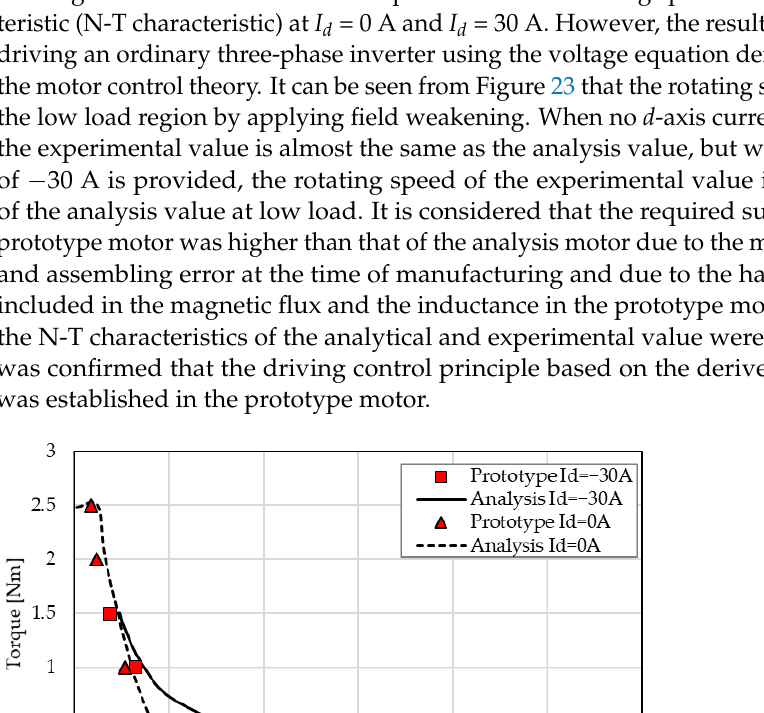
( b ) Figure 25. Analytical U-phase back e.m.f. before and after irreversible demagnetization at 1000 r/min: ( a ) waveforms; ( b ) FFT results. The prototype motor determines whether the magnet is demagnetized or not by com- paring the back e.m.f. before and after the characteristic measurement. Figure 26 shows the experimental waveforms and FFT results of the U-phase back e.m.f. before and after measurement. Figure 26 shows that the fundamental wave components are almost iden- tical before and after the experiment. Therefore, it was confirmed that there was virtually no significant degradation of motor characteristics due to irreversible demagnetization. ( a ) ( b ) Figure 26. U-phase back e.m.f. of the prototype motor before and after the experiment at 1000 r/min: ( a ) waveforms; ( b ) FFT results. 4. Comparison of Characteristics of Novel Consequent-Pole PM Motor 4.1. Motor Specifications The characteristics of the proposed novel consequence-pole motor, the conventional consequence-pole PM motor, and the standard surface permanent magnet (SPM) motor were compared in the analysis. Figure 27 shows a cross-section of the proposed novel consequence-pole motor, the conventional consequence-pole motor, and the SPM motor.